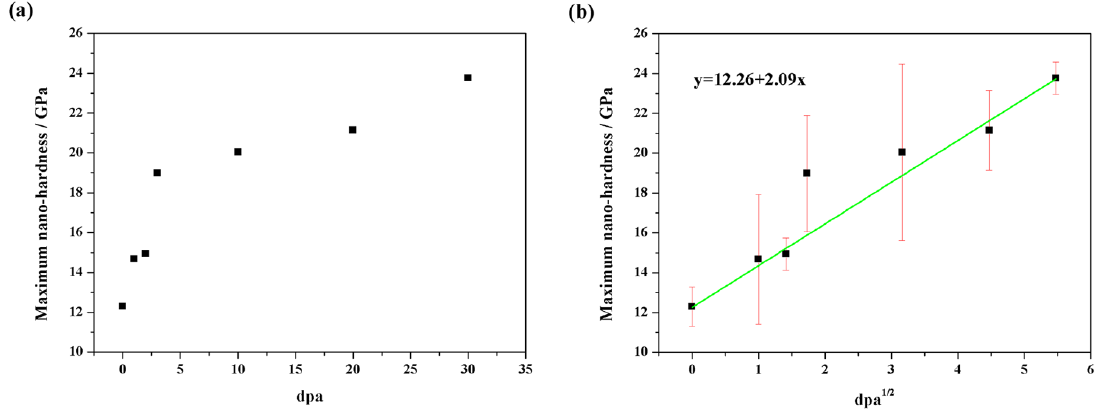
Figure 7. The relationship between the maximum nano-hardness and ( a ) dpa; ( b ) the square root of dpa.